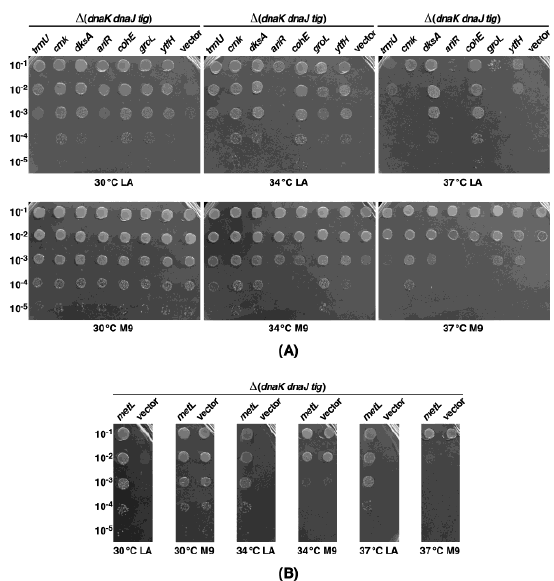
Figure 5. Overexpression of either the cmk gene or the dksA gene ( A ) or the metL gene ( B ) that act as multicopy suppressors of Δ6 ppi bacteria can restore the growth of a Δ( dnaK/J tig ) strain under non-permissive growth conditions. Exponentially grown cultures of the wild type and its isogenic ∆ ( dnaK dnaJ tig ) derivative transformed with either the vector pCA24N alone or the plasmid expressing the indicated gene were grown in minimal medium at 30 °C. Cultures were washed and adjusted to an optical density OD 600 of 0.1 and serially spot diluted on M9 minimal medium and LA medium at different temperatures in the presence of 75 μM IPTG.